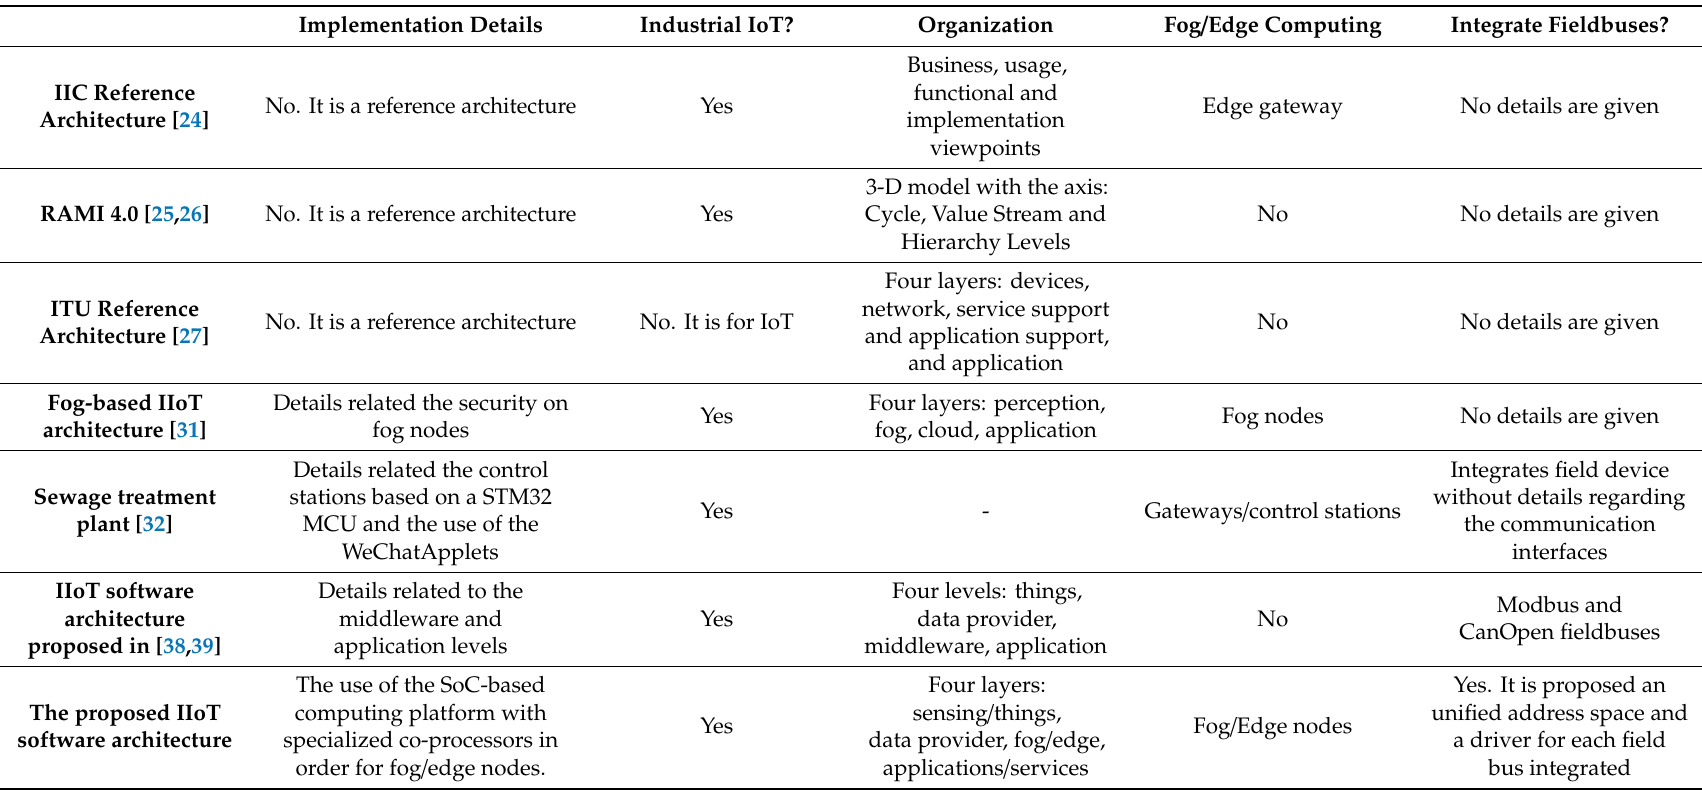
Table 1. A comparison between the proposed architecture and those described in Section